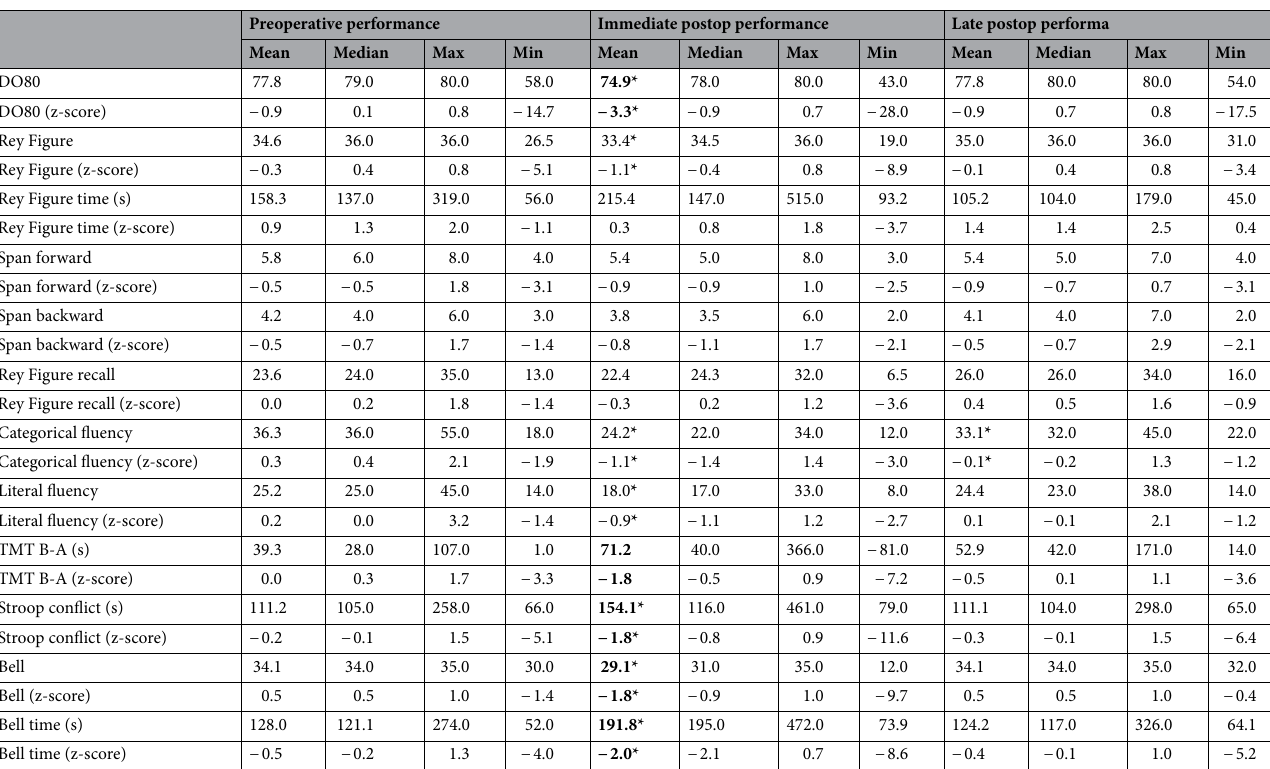
Table 3. Group-level analysis of cognitive performances. Raw scores and z-scores of the main cognitive tasks are given at preoperative, immediate postoperative and late postoperative evaluations. The values in bold are considered as pathologic (z-scores < − 1.5), while values with a star differed significantly ( p < 0.05) from their preoperative